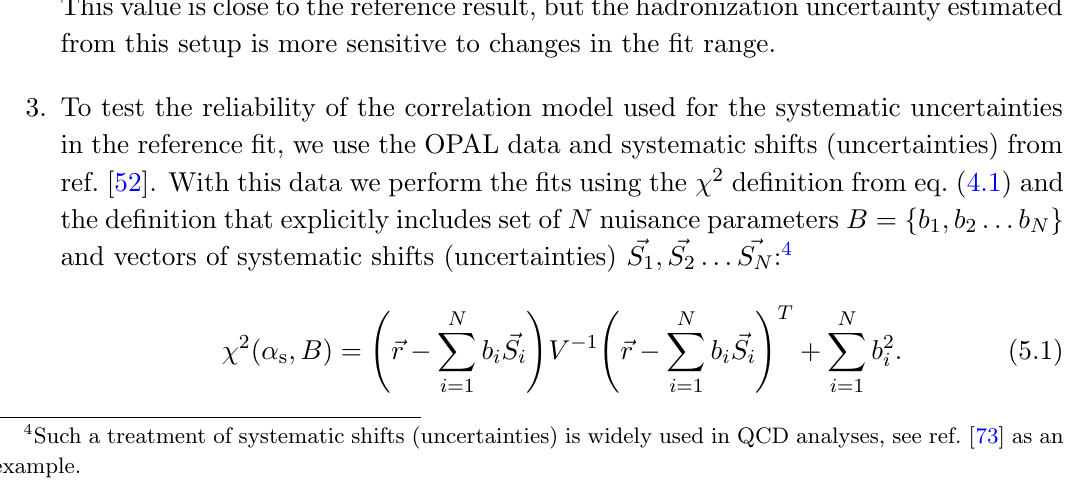
Figure 5 . Dependence of ( R 2 ) (cid:12)t results on the Only statistical uncertainties are